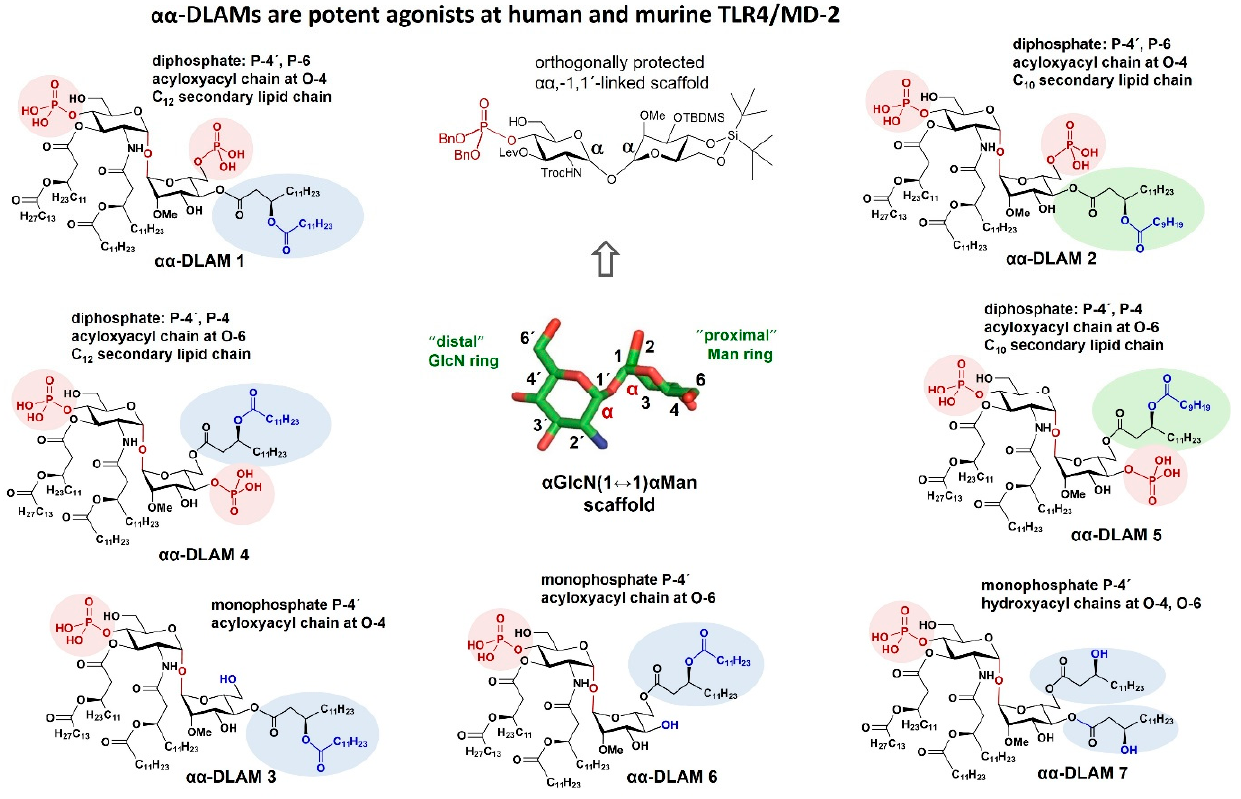
Figure 8. A library of synthetic disaccharide lipid A mimetics based on α GlcN(1 ↔ 1) α Man scaffold ( αα